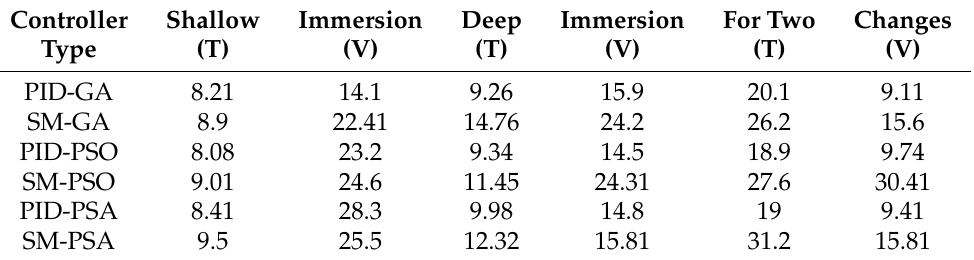
Table 4. Values of fitness function no. 3 for tuning (T) and verifying (V) BUV’s depth controllers for three changes of desired immersion: shallow, deep and two following depths